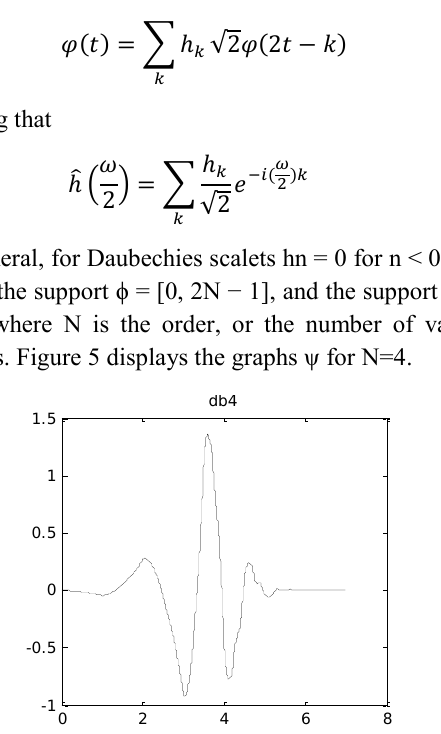
Figure 5: Daubechies Wavelets